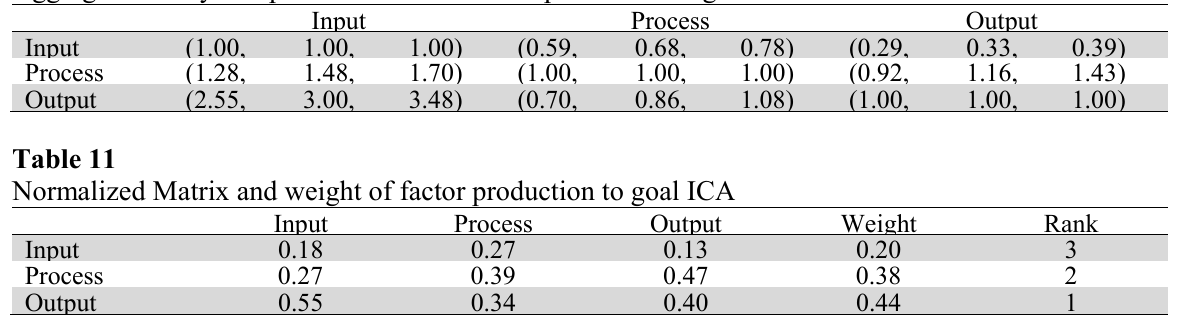
Aggregated fuzzy comparison matrix of factor production to goal ICA